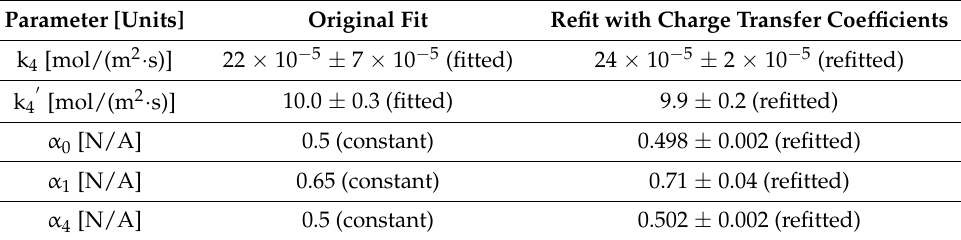
Table 2. Original fit and refitted parameter values with charge transfer coefficients for Pt 9